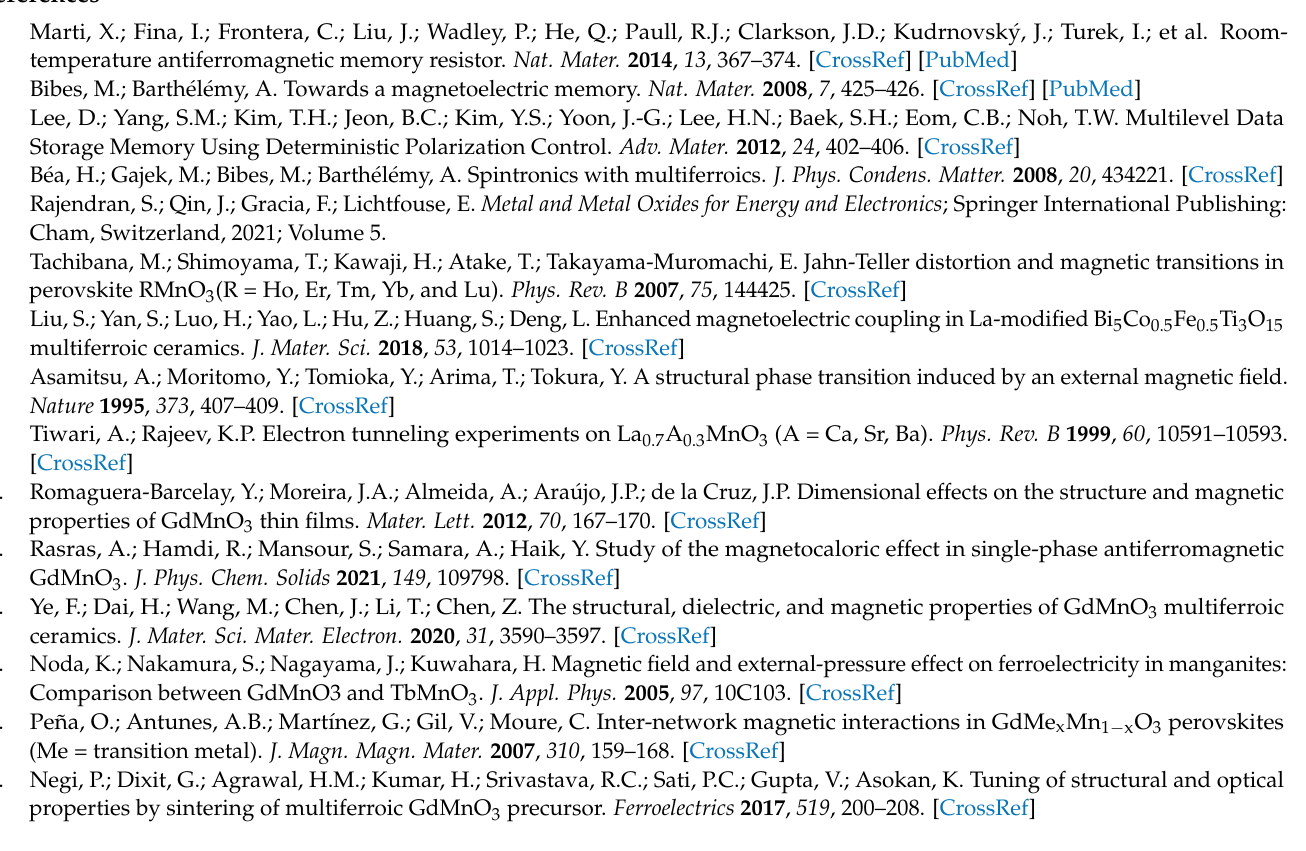
GdMnO850, Figure S2. 2D AFM topographic maps of (a,b) GdMnO650, (c,d) GdMnO750, and (e,f) GdMnO850., Figure S3. Graphical study of volume parameters (left) and Sk parameters (right) based upon the Abbott curve calculated for the samples: (a) GdMnO650, (b) GdMnO750, and (c)